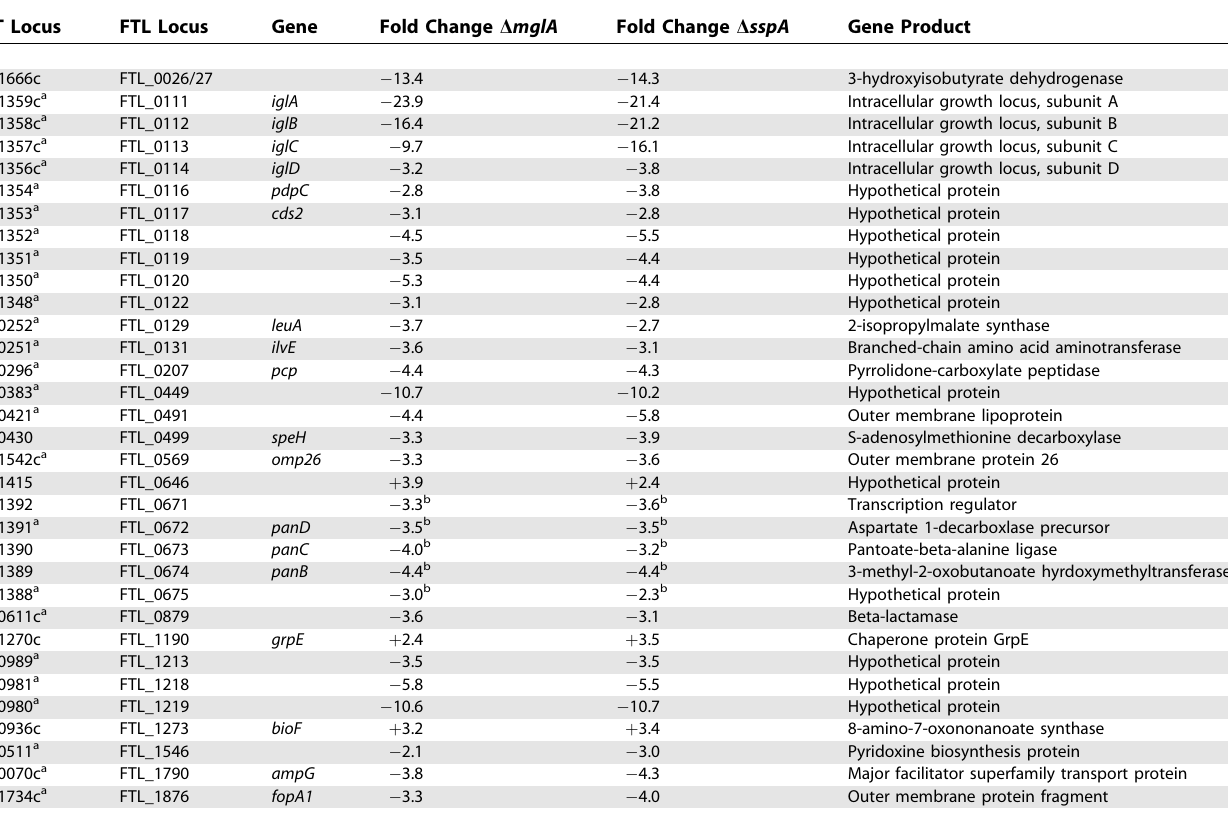
Table 1. Microarray Analysis of Genes Whose Expression Changes by a Factor of 3 or More in either a D mglA or a D sspA Mutant Background Compared to Wild-Type FTT Locus FTL